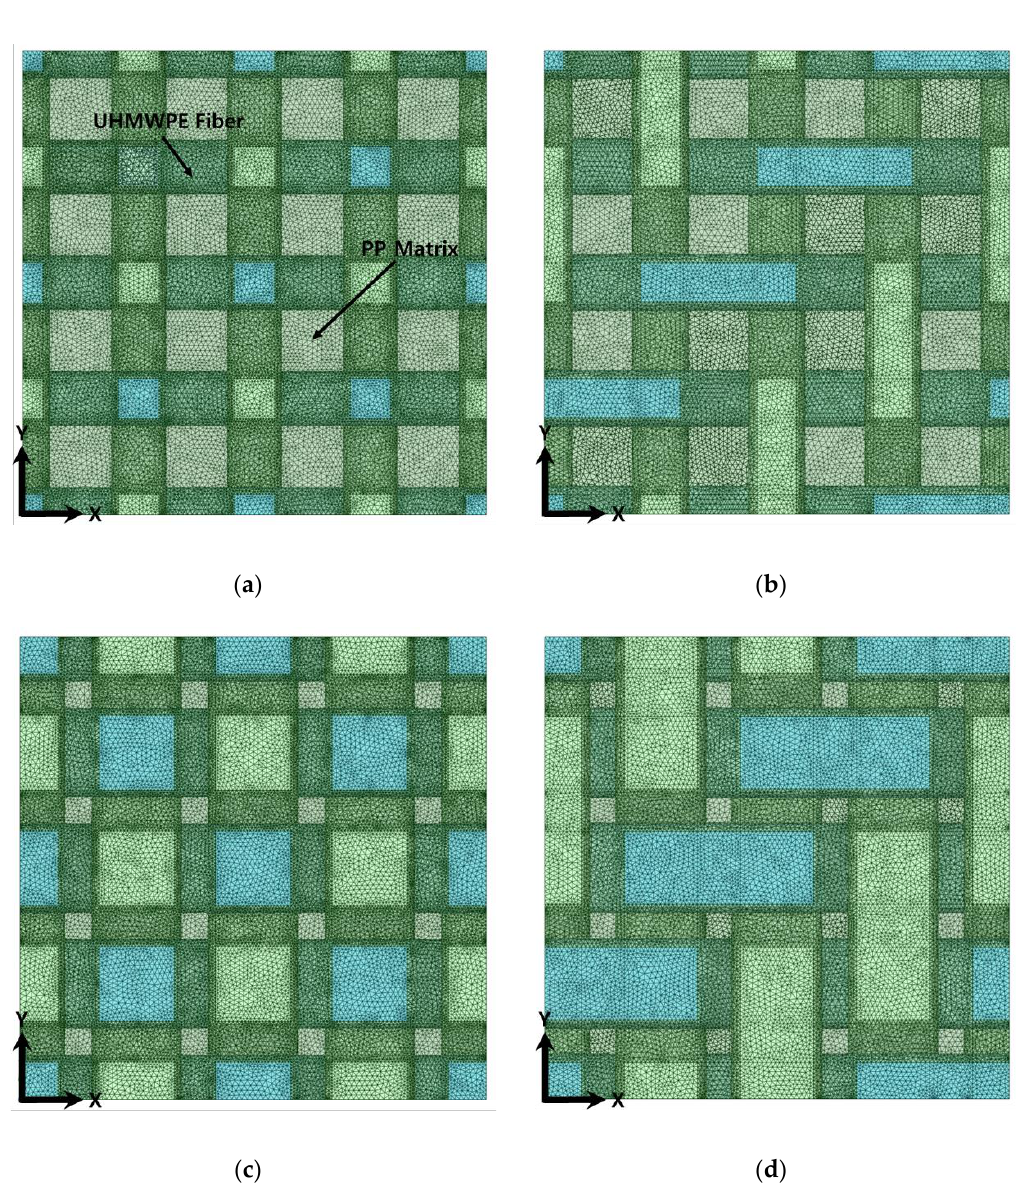
Figure 2. Textile compositions using the plain and twill weaving methods ( a ) Plain weave VF45, ( b ) Twill weave VF45, ( c ) Plain weave VF75, ( d ) Twill weave VF75.